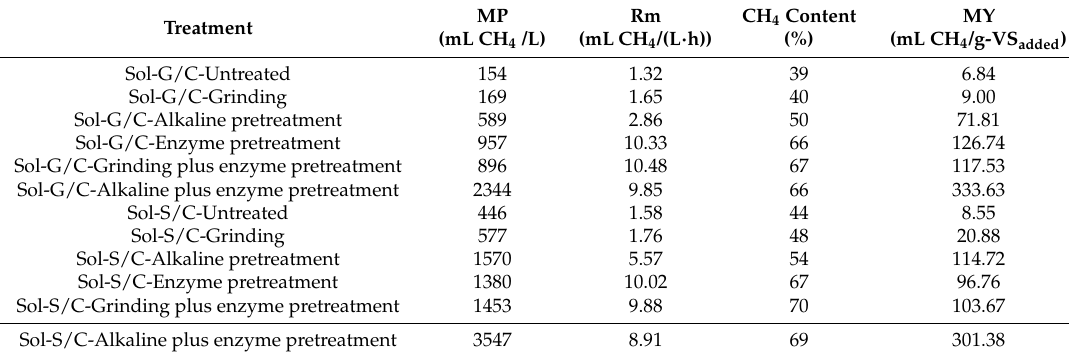
Sol-S / C: Solid residues from a co-digestion of silage with cow dung at ratio of 3:1.